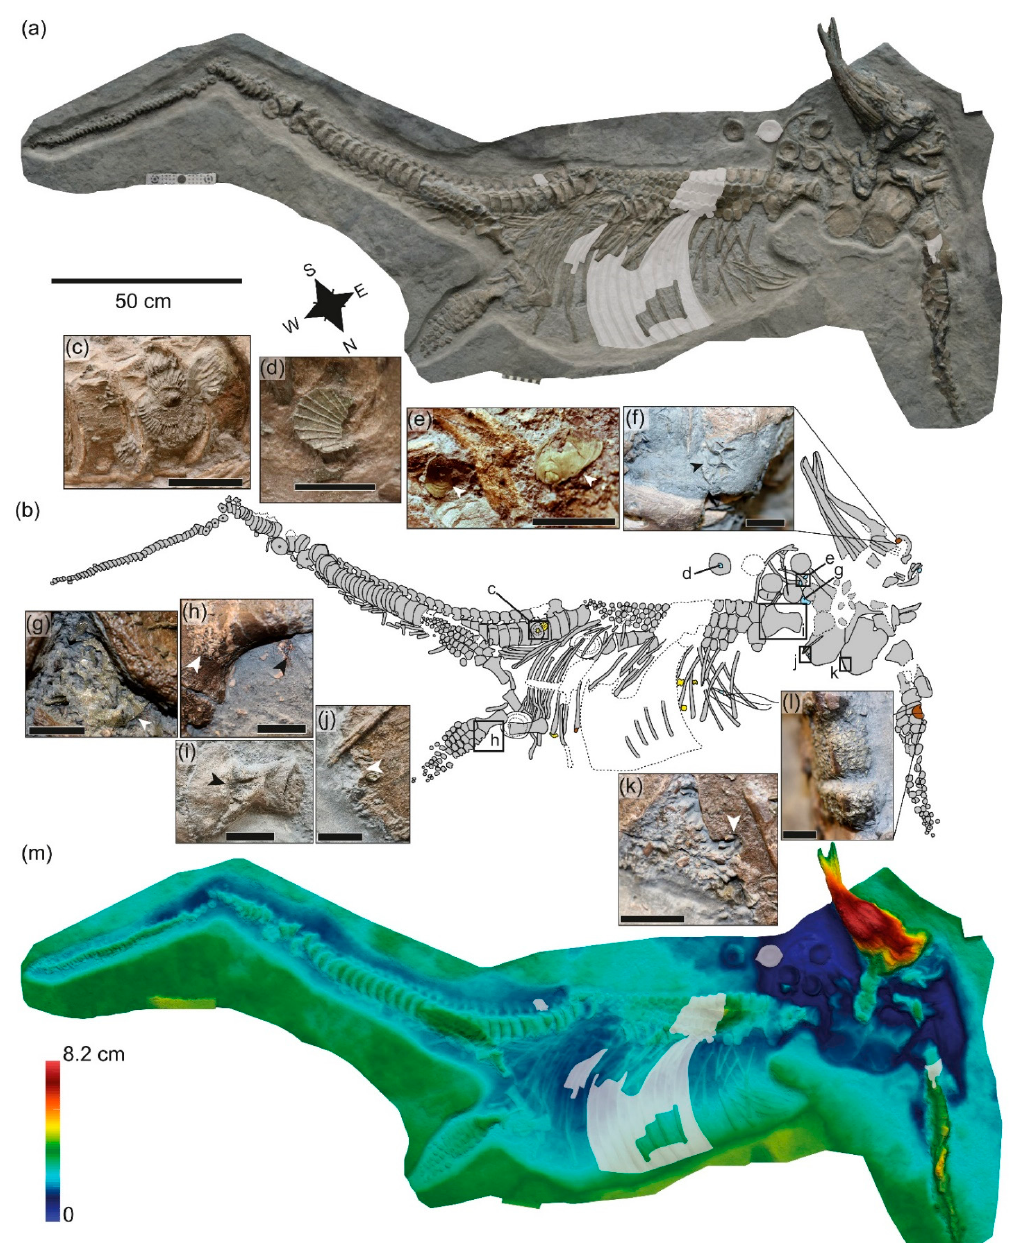
Figure 6. SMNS 81719, Stenopterygius uniter, prepared from below. ( a ) Orthophoto; grey shaded areas indicate reconstructed parts. ( b ) Interpretive drawing; dashed lines represent reconstructed areas of the skeleton. Yellow = invertebrates not associated with the skeleton; light blue = associated macroin- vertebrates; brown = invertebrates directly encrusting the bones. ( c ) Ammonite ( Dactylioceras ) with lower surface encrusted with Liostrea showing xenomorphic sculpture; ( d ) Propeamussium pumilus ; ( e ) Parainoceramya dubia ; ( f ) Liostrea encrusting skull; ( g ) Plagiostoma sp.; ( h ) hind limb showing buff- colored crust and dark-colored film; ( i ) potential bioerosion on the right humerus; ( j ) right and ( k ) left coracoids, showing damaged area surrounded by bone fragments; ( l ) Liostrea encrusting forelimb ele- ments; ( m ) false-color depth map showing relative topography of the specimen. Warmer colors (reds) indicate deeper penetration of the bones into the sediment; cooler colors (blues) indicate elements closer to the sediment surface. Grey shaded areas indicate reconstructed parts. Scale bars = 50 cm ( a ), 10 mm ( d , f , g , l ); 20 mm ( e , h , j , k ); 40 mm ( c ); 50 mm ( i